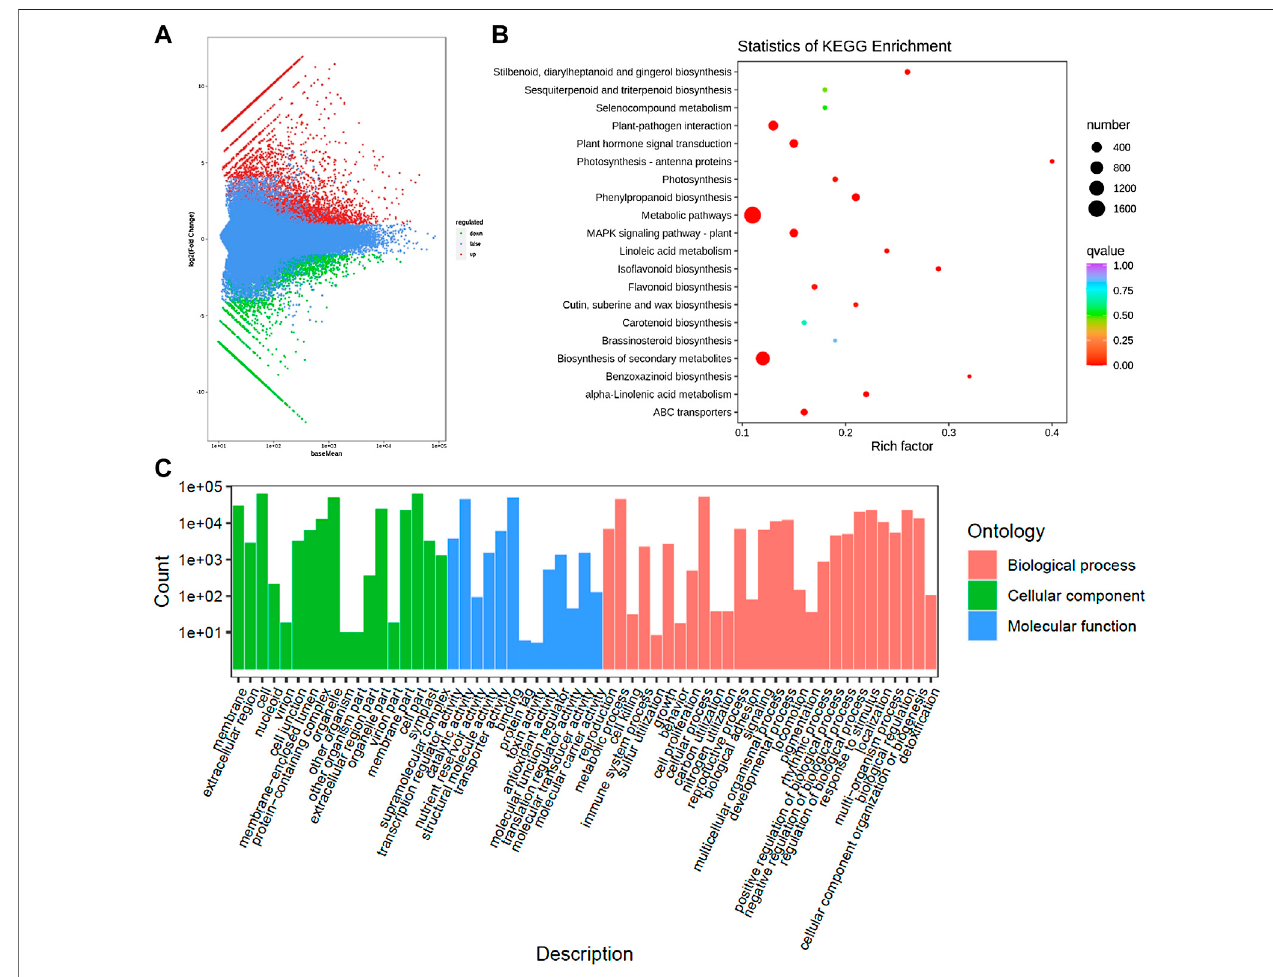
FIGURE 3| (A) Differential gene MA map. The ordinate represents the log2 fold change value; the abscissa represents the average value of gene expression in the two samples; the red dot represents the upregulation of the gene expression, and the green dot represents the downregulation of the expression. Blue indicates no signi fi cant difference in gene expression. (B) Kyoto encyclopedia of genes and genomes (KEGG) enrichment scatter plot. The ordinate represents the KEGG pathway. The abscissa represents the Rich factor. And (C) Histogram of GO classi fi cation of the DEGs between CMCs and DDCs.